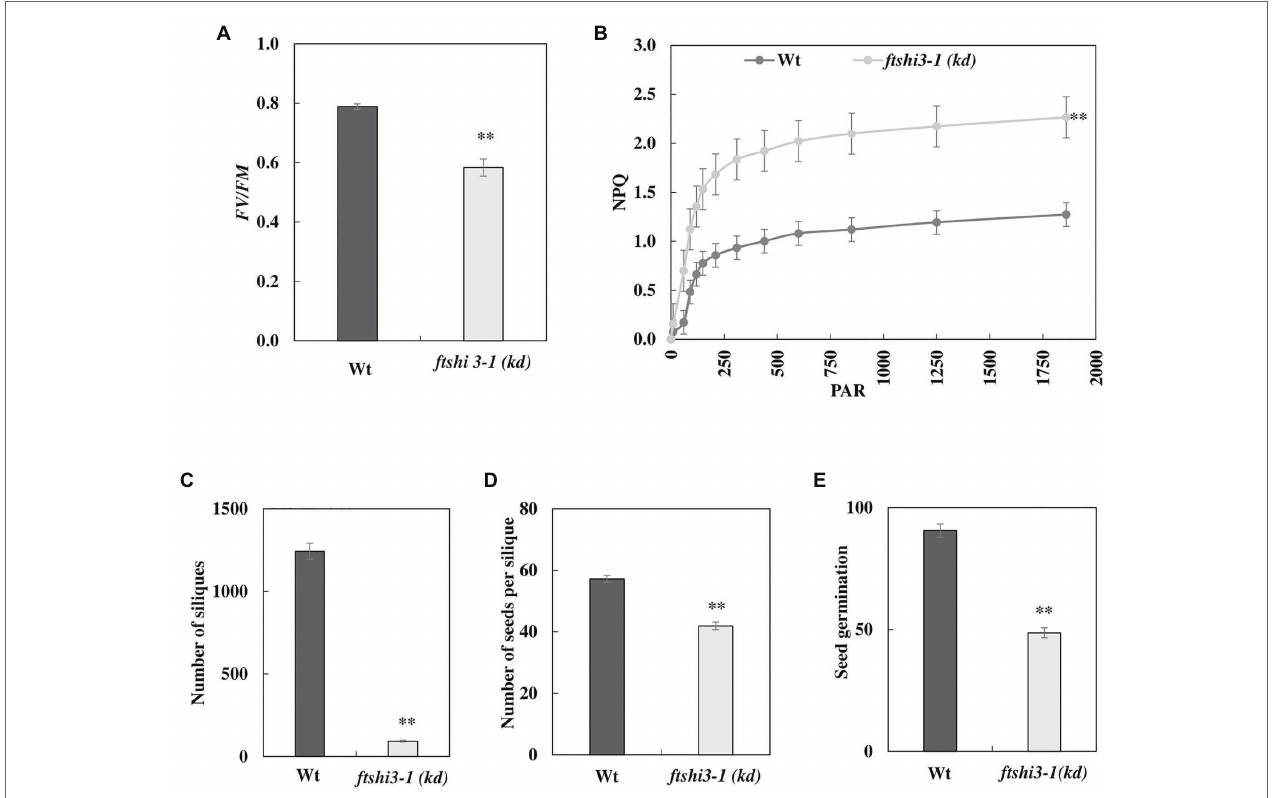
FIGURE 3 | (A) Chlorophyll fluorescence indicating photosynthetic parameters ( Fv/Fm ) and (B) non-photochemical quenching (NPQ) of Wt and ftshi3-1(kd) measured on plants growing in the field. Asterisks indicate a significant difference ( p < 0.05, Student’s t test, n = 8). The number of (C) siliques and (D) seeds per silique. Asterisks indicate a significant difference [ ** p < 0.001, ANOVA, least significant difference (LSD) post hoc test, n = 50]. (E) Seed germination capacity (determined after 2 days of incubation) of seeds harvested from field-grown plants. Asterisks indicate a significant difference ( ** p < 0.001, ANOVA, LSD post hoc test, n = 50). Error bars represent the